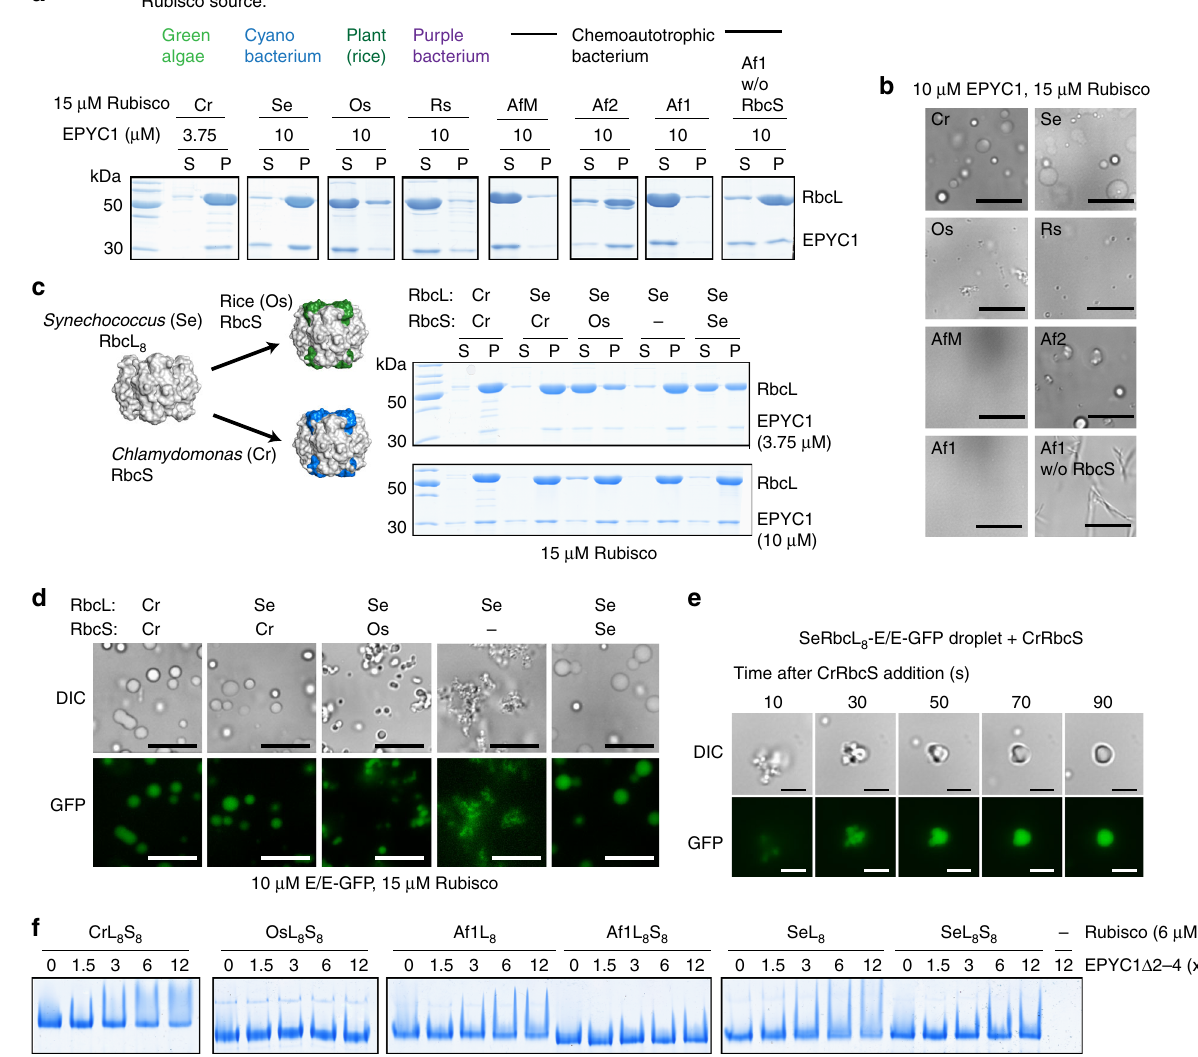
Fig. 4 Diverse Rubisco enzymes vary in their tendency to demix with EPYC1. a , b The tendency of a phylogenetically diverse set of Rubisco enzymes to demix was assessed using the sedimentation assay ( a ) and microscopy ( b ). Scale bar 15 µ m. c , d The role of the small subunit in demixing was assessed using chimeric Rubiscos ( Synechococcus large subunit cores (L 8 ) either lacking, or assembled with small subunits from rice (Os) or Chlamydomonas (Cr). Sedimentation ( c ) and microscopy ( d ) assays are shown. Scale bar 15 µ m. e Addition of external CrRbcS (4 µ M) rapidly changes the appearance of SeL 8 (2.5 µ M)-EPYC1/EPYC1-GFP (1.25/0.1 µ M) droplets. Scale bar 5 µ m. f Native PAGE gel-shift assay using Rubisco and the single-repeat variant EPYC1 Δ 2-4 indicates increased binding for Rubiscos lacking the small